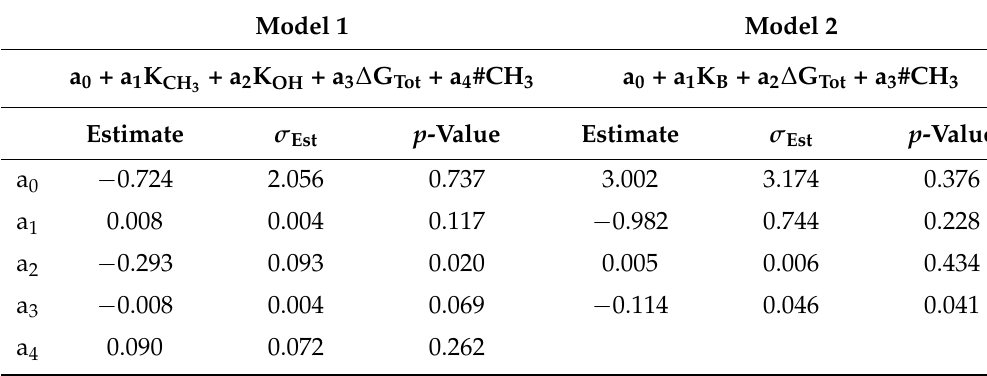
Table 2. Summary of Models 1 and 2, trained to ∆